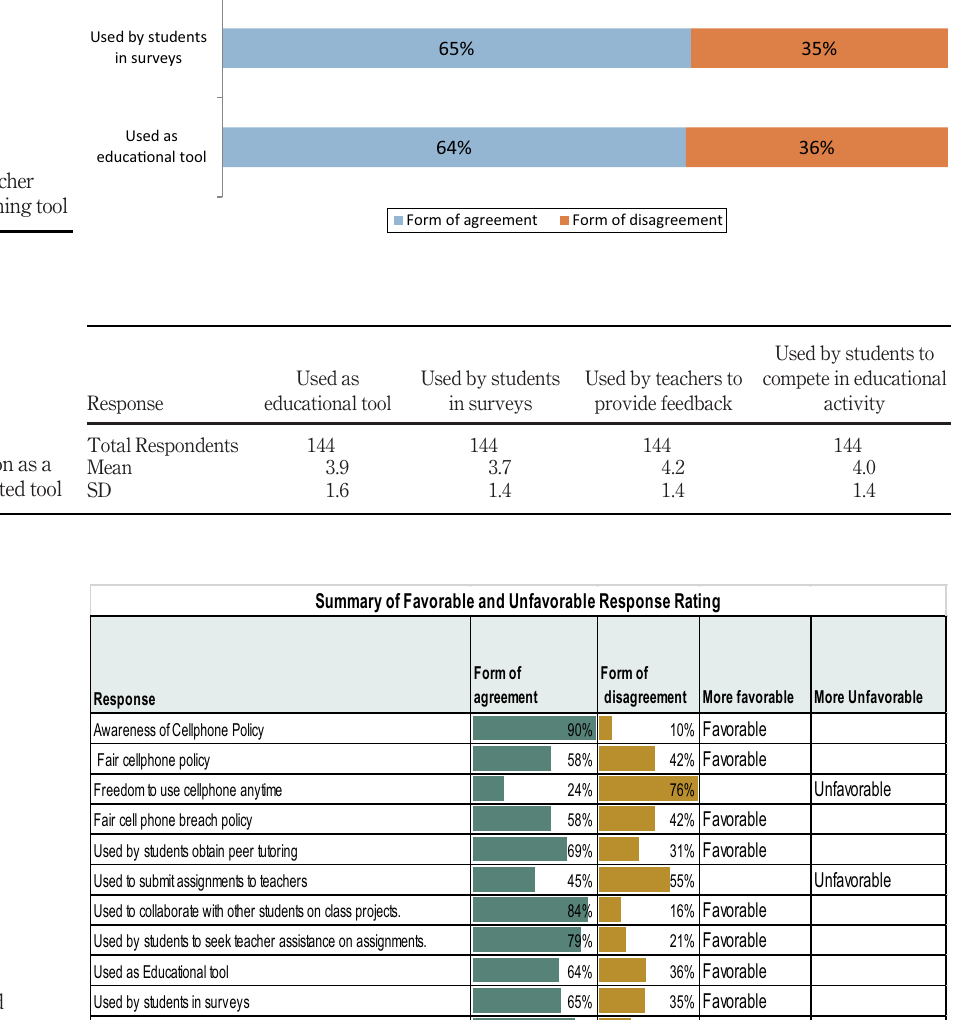
Figure 11. Favorable vs